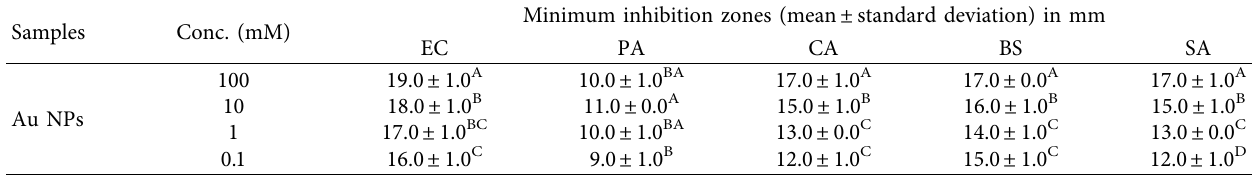
Table 1: Minimum inhibition zones for Au NPs of different concentrations synthesized from Physalis peruviana. Samples Conc. (mM)